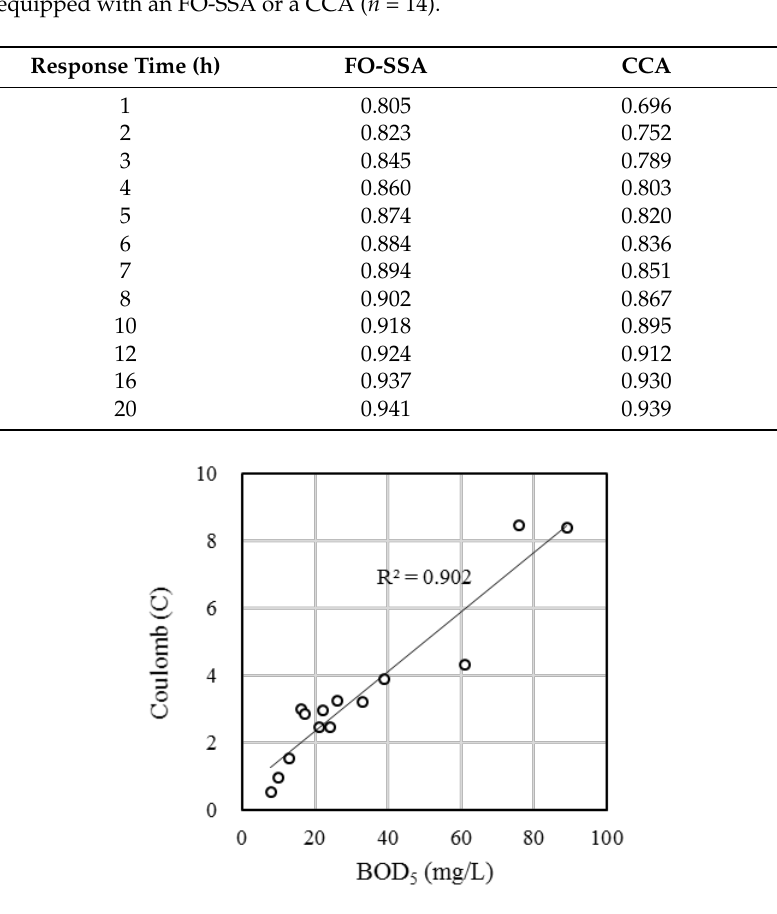
Figure 3. Correlation between coulomb and BOD 5 at a response time of 8 h in the FO-SSA-equipped